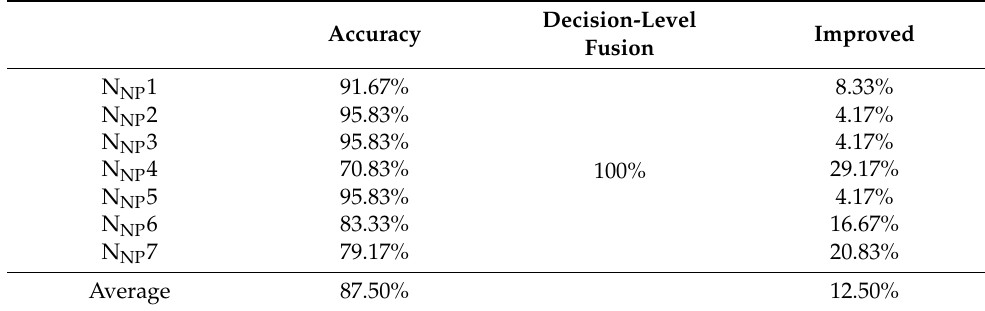
Table 5. Comparisons of the detection results before and after the decision-level fusion.